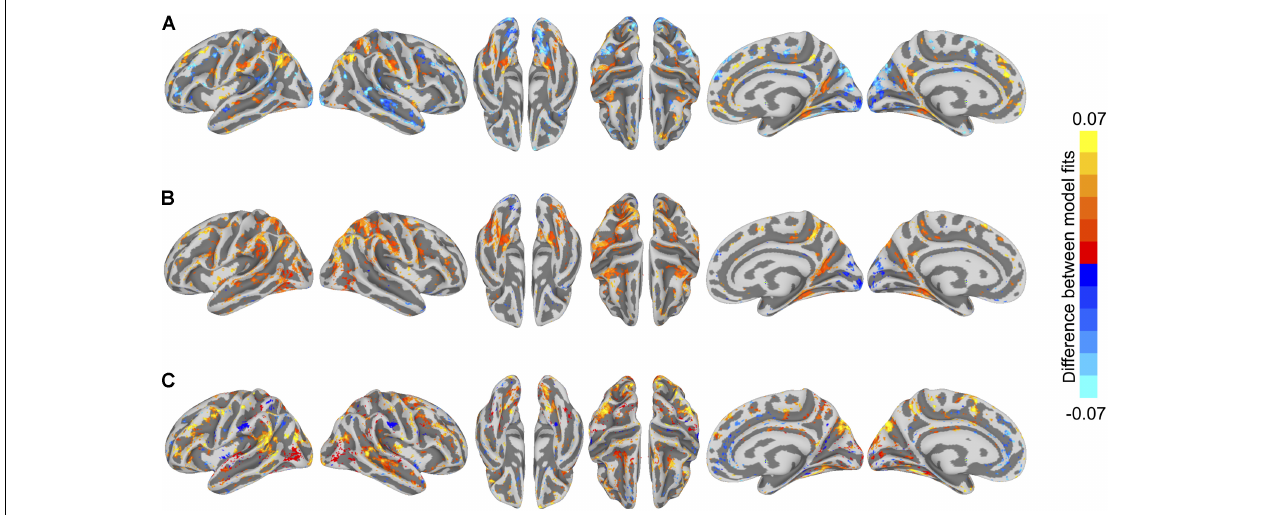
FIGURE 5 | Differences in semantic encoding model performance maps. (A) Paired differences in model performance between between-subject models using anatomical normalization and within-subject models. Warm colors indicate vertices where the anatomically aligned between-subject model performance exceeds within-subject model performance, and cool colors indicate where within-subject model performance exceeds anatomically aligned between-subject model performance. (B) Paired differences in model performance between between-subject models using hyperalignment and within-subject models. Warm colors indicate vertices where the hyperaligned between-subject model performance exceeds within-subject model performance, and cool colors indicate where within-subject model performance exceeds hyperaligned between-subject model performance. (C) Paired differences in model performance for between-subject models using hyperalignment and anatomical normalization. Warm colors indicate vertices where the hyperaligned between-subject model performance exceeds anatomically aligned between-subject model performance, and cool colors indicate where anatomically aligned between-subject model performance exceeds hyperaligned between-subject model performance. Colored vertices reflect mean paired differences in model performance, thresholded at an absolute t -value of t (17) = 2.11, p < 0.05, uncorrected for multiple comparisons.